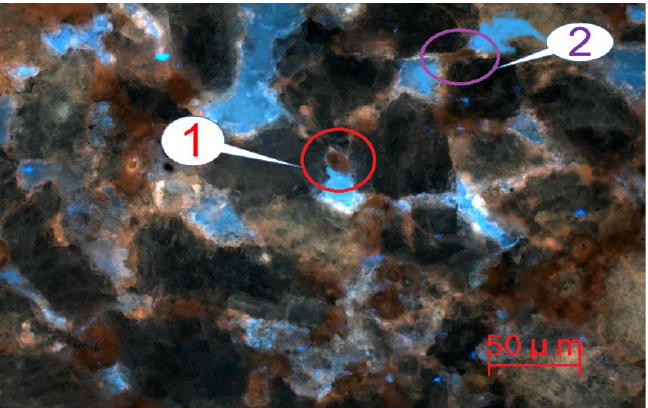
Figure 10. Schematic diagram of remaining oil types in a semi-bound state.